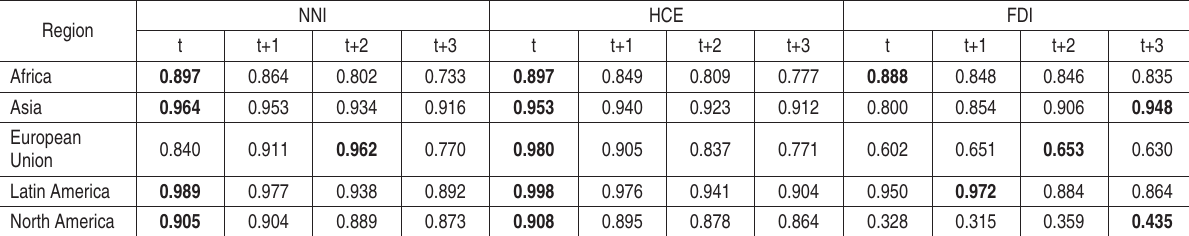
Table 1. The results of lag correlation determining between access expansion to insurance services and financial and economic parameters